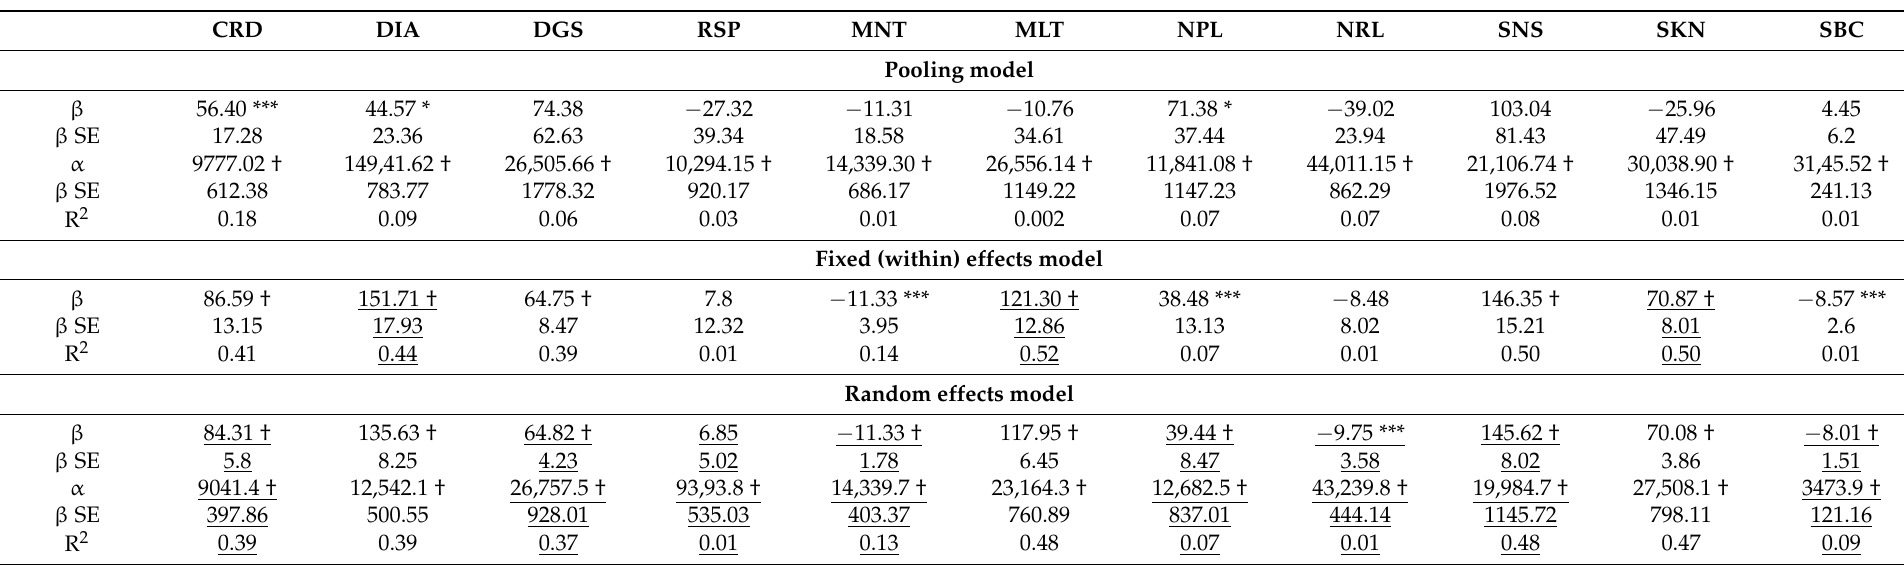
Table 6. Outputs of PLM models: RNWe heating and cooling (%) → prevalence of selected diseases (per population of